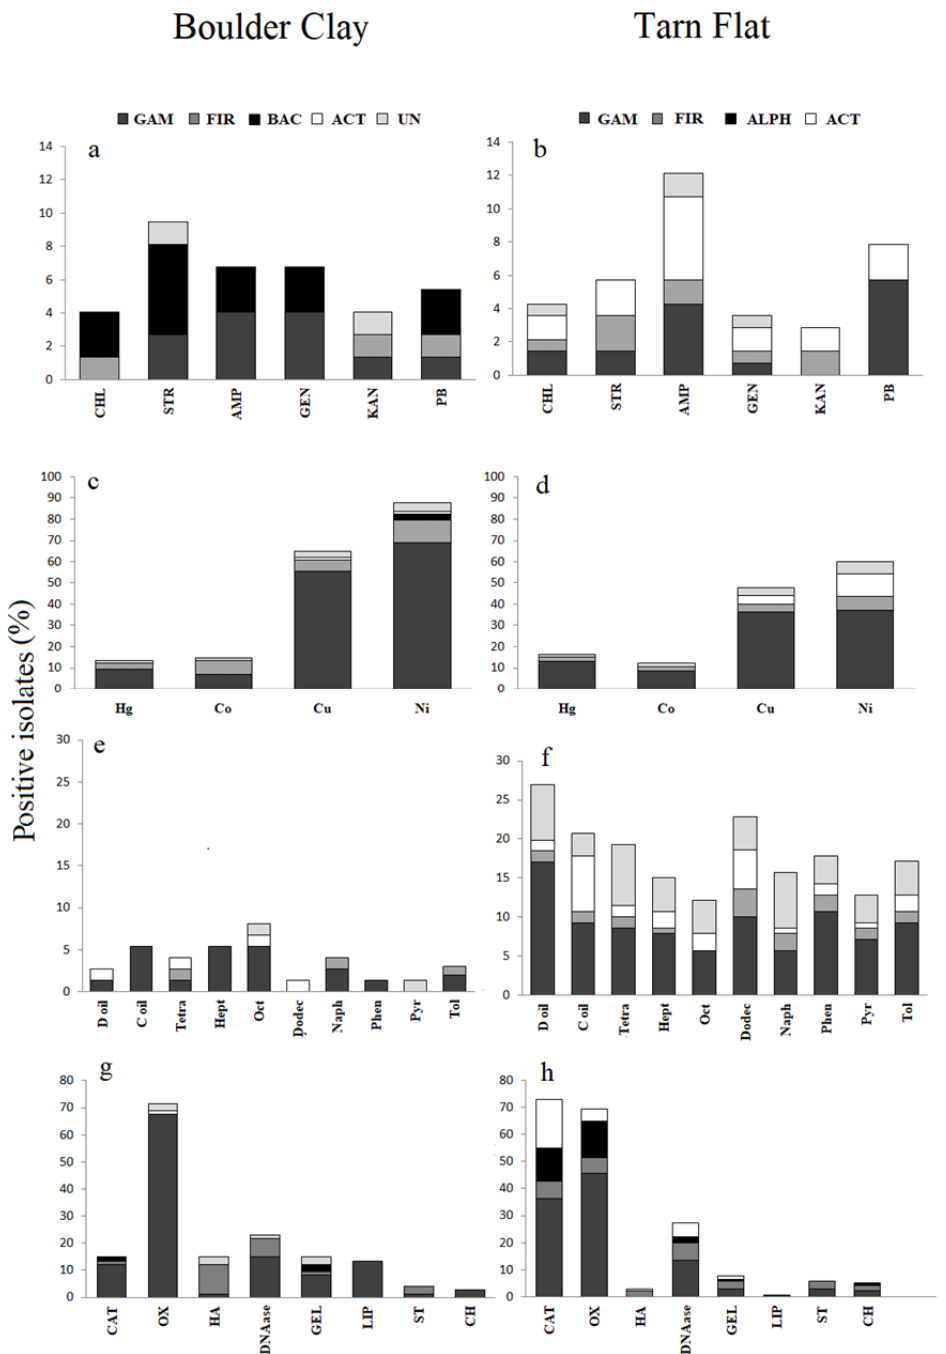
Figure 5. Ecological and biotechnological features of bacterial isolates. ( a , b ) Antibiotic susceptibility of BC and TF isolates (CHL, chloramphenicol; STR, streptomycin; AMP, ampicillin; GEN, gentamycin; KAN, kanamycin; PB, polymyxin B). ( c , d ) Resistance to heavy metals of BC and TF isolates (Hg, Mercury; Co, Cobalt; Cu, Copper; Ni, Nichel. ( e , f ) Oxidation of aliphatic and aromatic hydrocarbons by BC and TF isolates (D oil, Diesel oil; C oil, Crude oil; Tetra, Tetradecane; Hept, Heptane; Oct, Octane; Dodec, Dodecane; Naph, Naphtalene; Phen, Phenantrene; Pyr, Pyrene; Tol, Toluene. ( g , h ) Enzymes detected in BC and TF isolates (CAT, catalase; OX, oxidase; HA, haemolytic activity; DNAase, DNAse; GEL, gelatinase; LIP, lipase / esterase, ST, amylase; CH, chitinase.